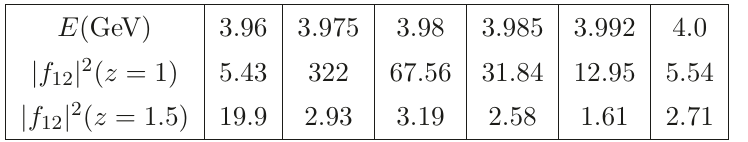
Table 4 . The values of the transition probability as a function of energy in the transition 3)